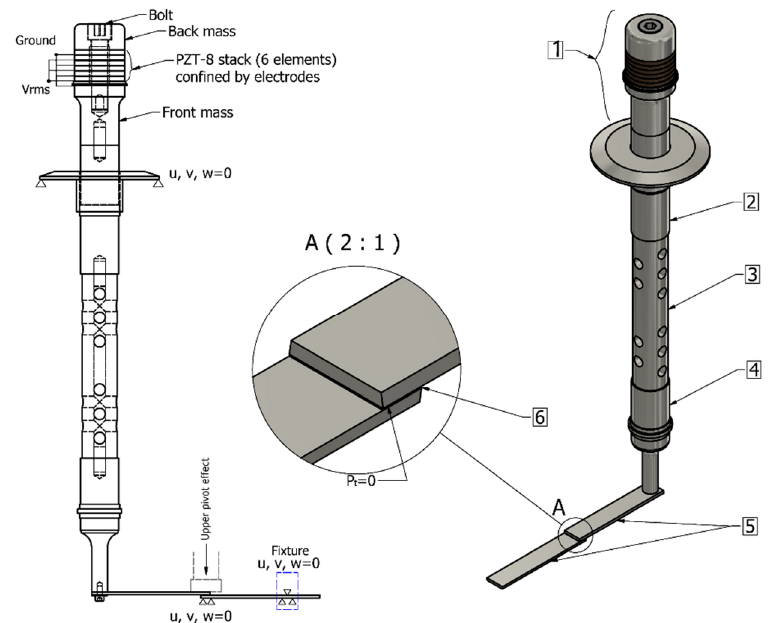
Figure 6. The studied ultrasonic brazing stack with a 20 kHz transducer (Ti-6Al-4V front